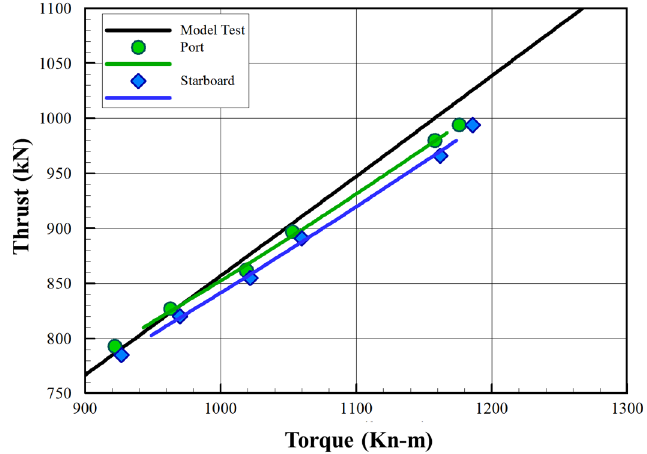
Figure 11. Comparison of thrust–torque of the twin skeg LNG carrier.